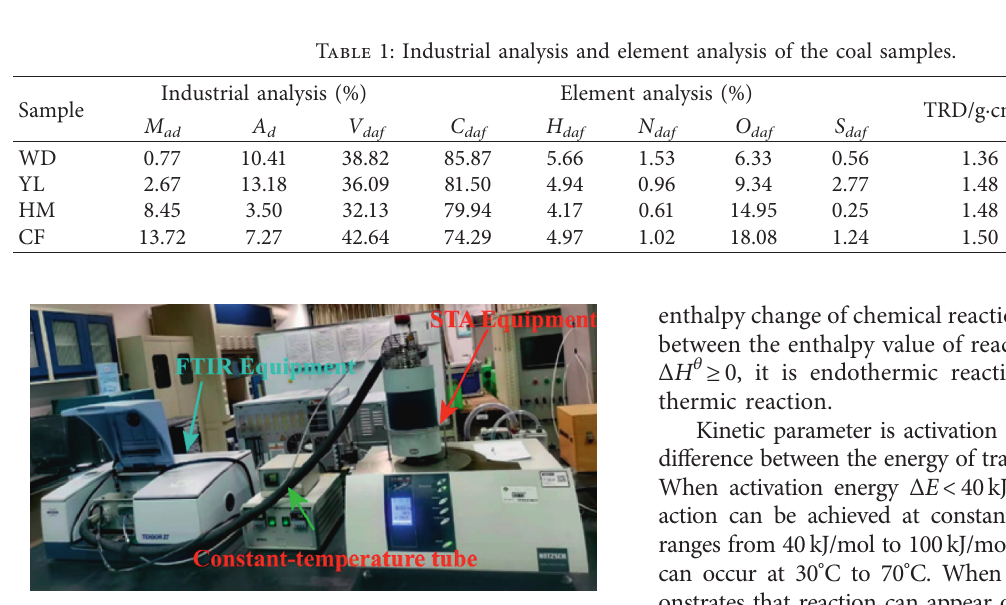
Figure 1: STA-FTIR experimental